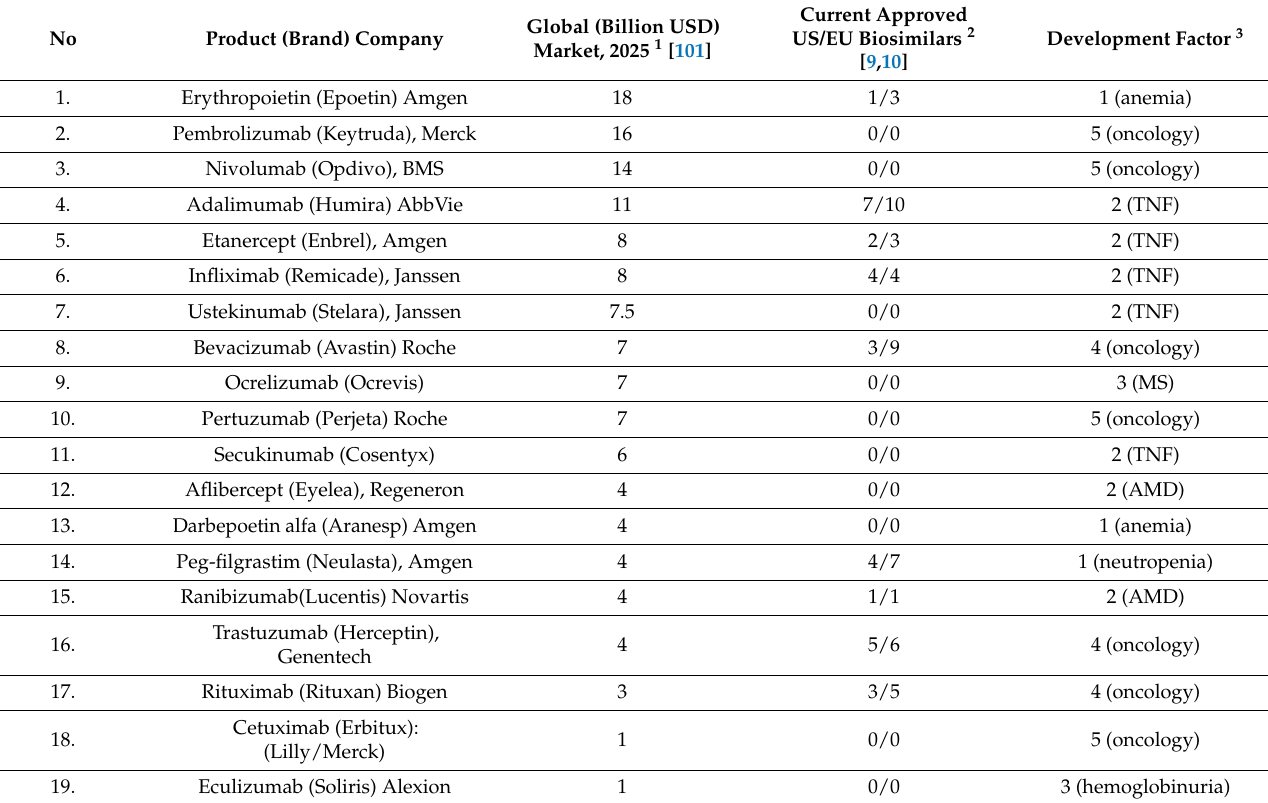
Table 2. The projected market of biologicals in the year 2025 as impacted by the entry of biosimilars and the development